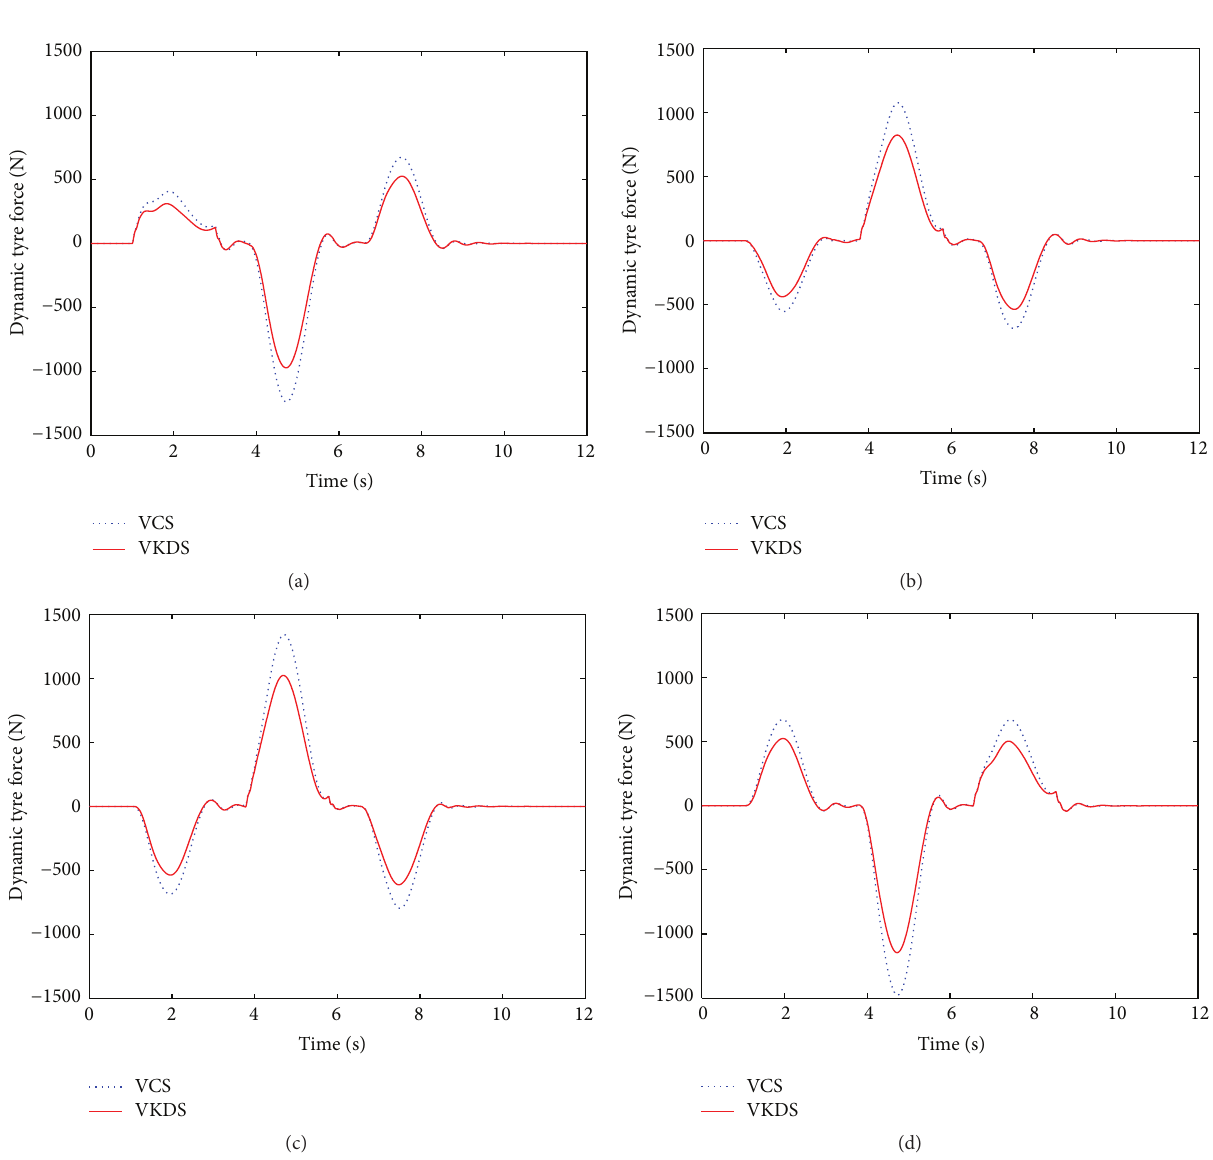
Figure 14: (a) Dynamic tyre force of the VCS and VKDS in front left wheel. (b) In front right wheel. (c) In rear left wheel. (d) In rear right